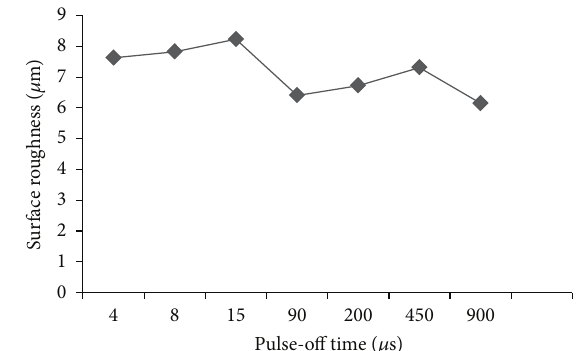
Figure 19: Influence of pulse-off time on SR at constant current 9 Amp, gap voltage 60V, and pulse-on time 90 𝜇 s.